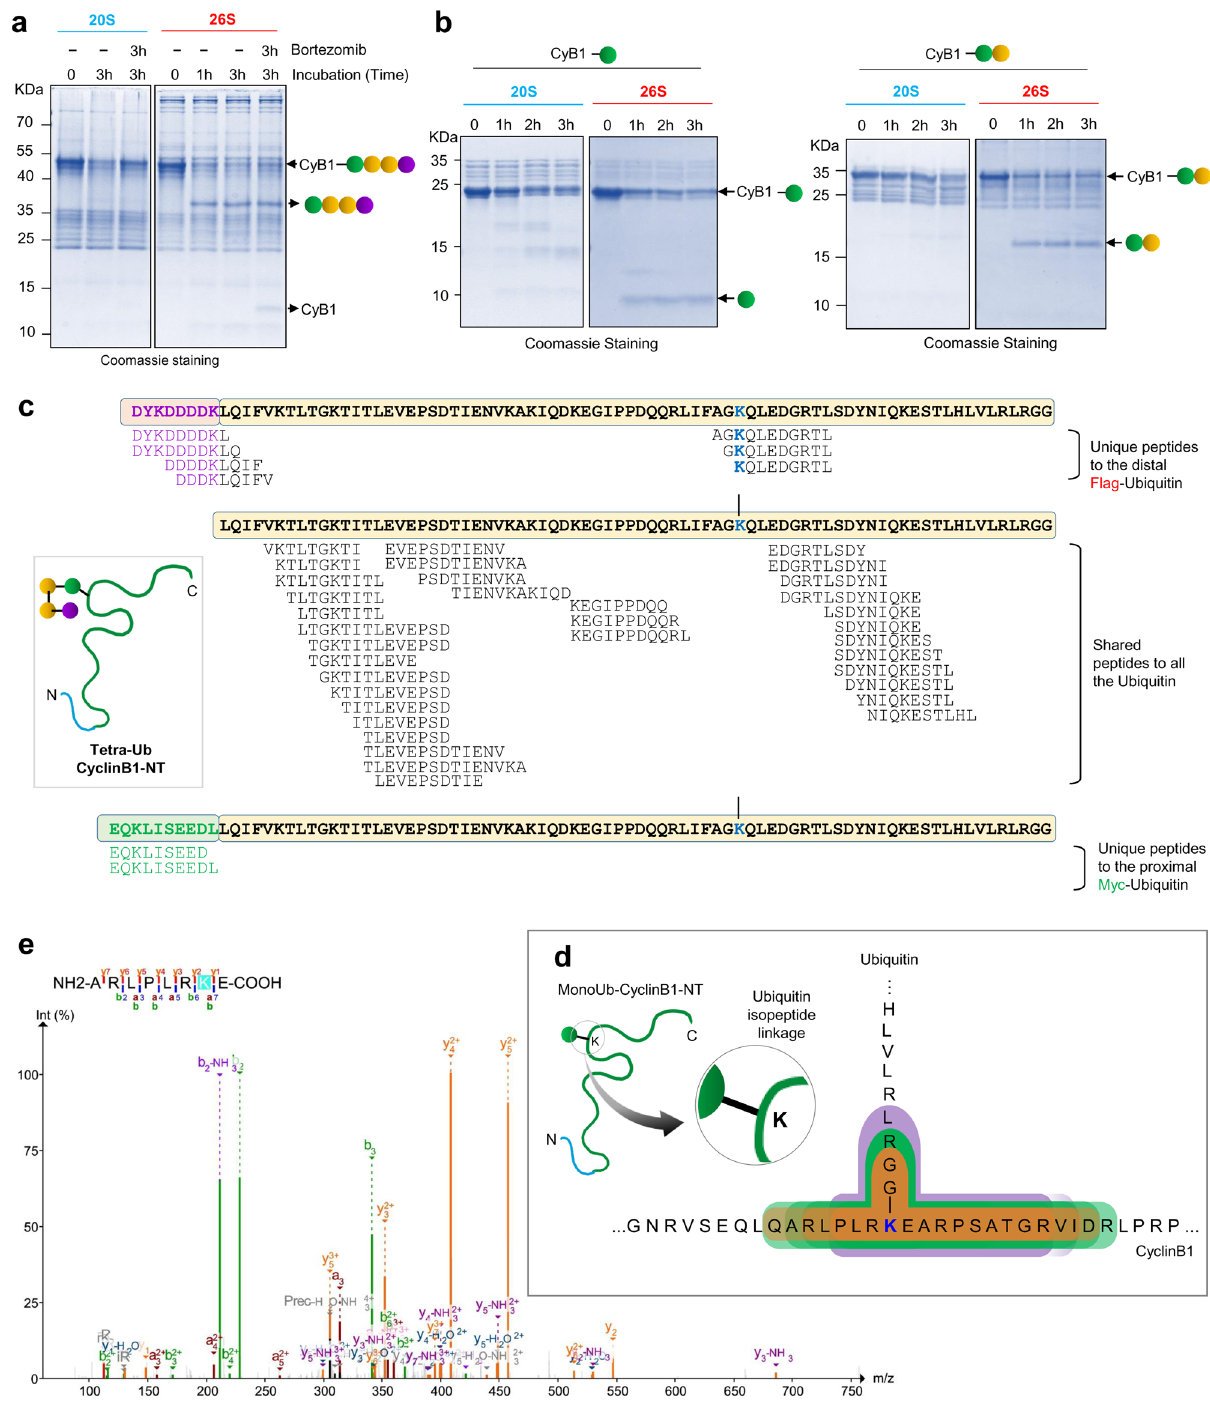
Fig. 3 Conjugated ubiquitin is proteolyzed by puri fi ed 20S proteasome in vitro. a TetraUb-Cyclin B1-NT was incubated with puri fi ed 20S or 26S proteasomes at 1:150 (proteasome:substrate) molar ratio at 37 °C for indicated time periods. The reaction mixture was resolved by Tris-Tricine PAGE and stained with Coomassie. Brotezomib was added to reactions to inhibit the proteasome activity. b MonoUb- or DiUb-Cyclin B1-NT were incubated at 37 °C with puri fi ed 20S or 26S proteasomes at 1:150 (proteasome:substrate) molar ratio for indicated time periods and separated in Tris-Tricine PAGE followed by Coomassie staining. c The illustration represents the ubiquitin peptides obtained from TetraUb-Cyclin B1-NT proteolyzed by the 20S proteasome detected by MS/MS analysis overlaid on the primary sequences of the ubiquitin units in the chain. Purple-colored residues represent the Flag-tag sequence on the distal ubiquitin unit, while green represents the Myc-tag sequence on the proximal ubiquitin. d The illustration represents the branched peptides at the isopeptide linkage of the C-terminus of ubiquitin to the K64 residue of cyclin B1 identi fi ed by non-tryptic MS/MS of reaction products. Three major types of branched peptides at K64 of Cyclin B1 were detected with variants of ubiquitin remnants: K64 — GG, K64 — GGR, and K64 — GGRL. e MS/MS spectra of one of the detected branched peptides ARLPLPKE with a GGR branch on K. Source data are provided as a Source data fi